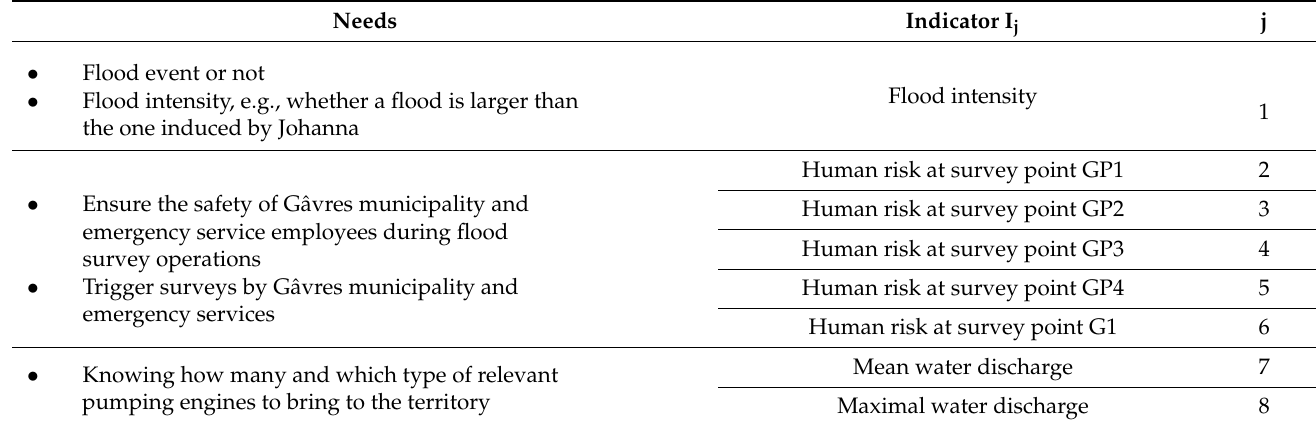
Table 1. Selected user needs and associated